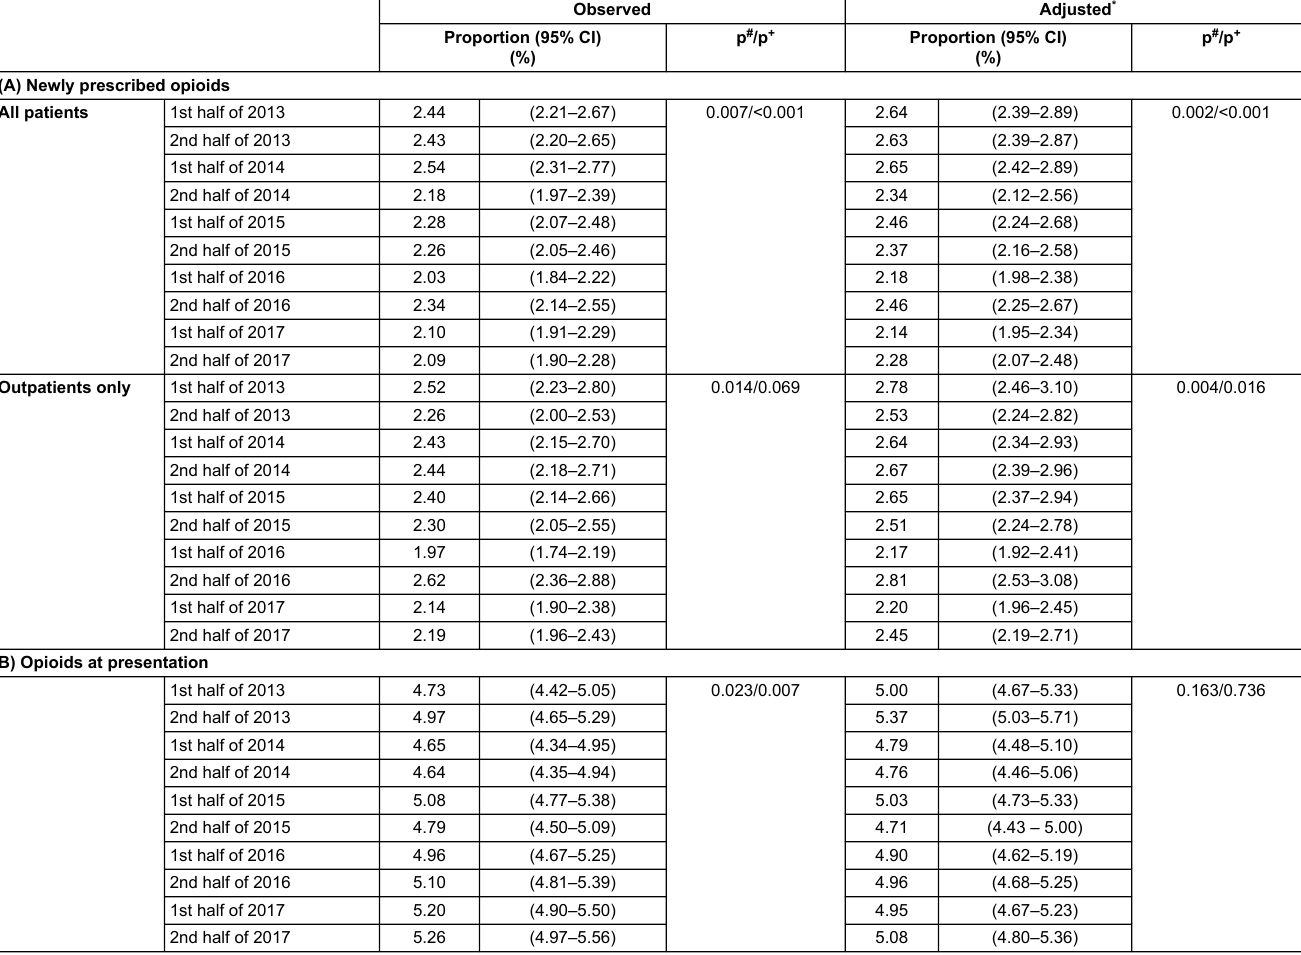
Table S1: Observed and adjusted proportions with 95% CI for (A) incident (newly prescribed) and (B) prevalent opioid medication on presentation, over the study